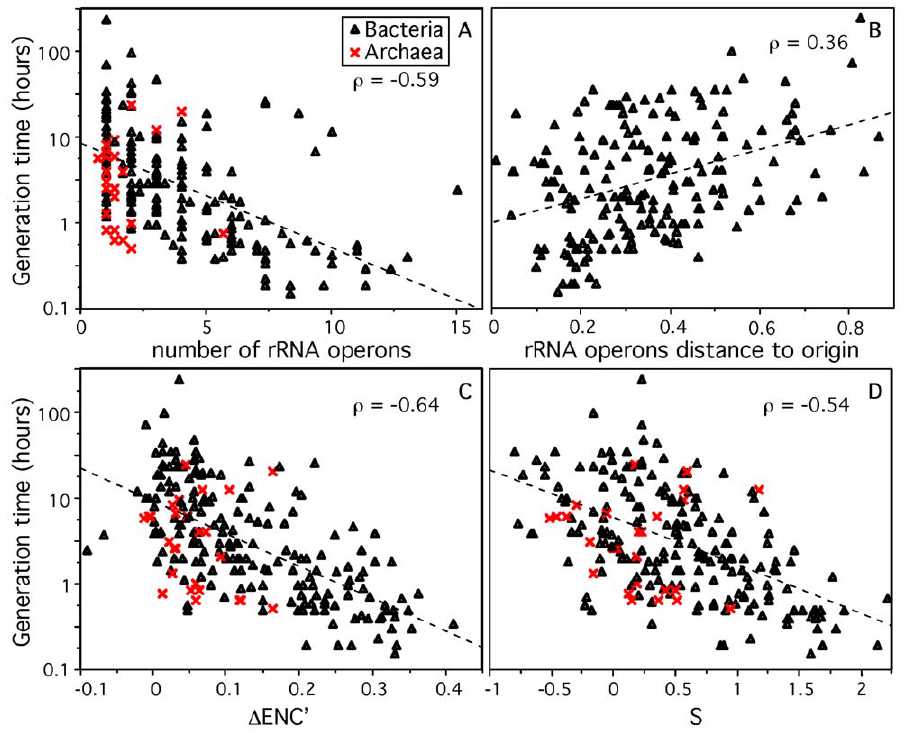
Figure 1. Genomic signatures correlated to minimum generation time (d) for 214 prokaryotes. Correlation between d and (A) the number of rRNA operons in the genome, (B) the relative distance from the origin of replication to rRNA genes (excluding species with no retrievable origin), 0.5 corresponds to half the replicon, (C,D) codon usage bias indices D ENC 9 [35] and S [46]. Spearman correlations are given ( r ) with all p- values , 0.0001. Dashed lines represent the trend of the